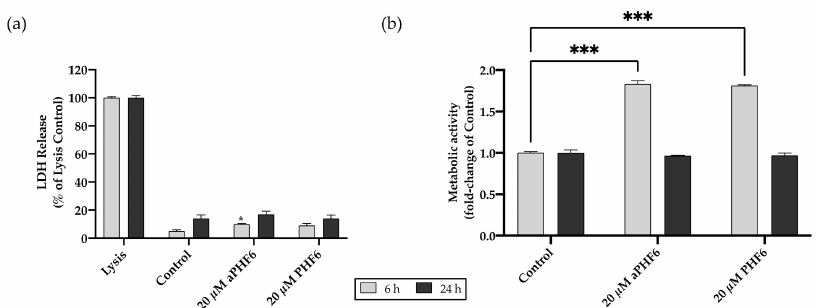
Figure 2. Effect of PHF6 stimulation on HMC3 cell viability and metabolic activity at 6 and 24 h. ( a ) Cell viability assay: Treatment with 20 µ M aggregated PHF6 (aPHF6) or 20 µ M unaggregated PHF6 (PHF6) did not significantly affect the LDH release at 6 or 24 h. ( b ) Metabolic activity assay: The CTB assay revealed increased metabolism after 20 µ M aPHF6 and PHF6 stimulation at 6 h, whereas no changes in any treatment group after 24 h were detected. Maximal lysed cells are treated as 100% or 1.0 positive control. * p < 0.05; *** p <